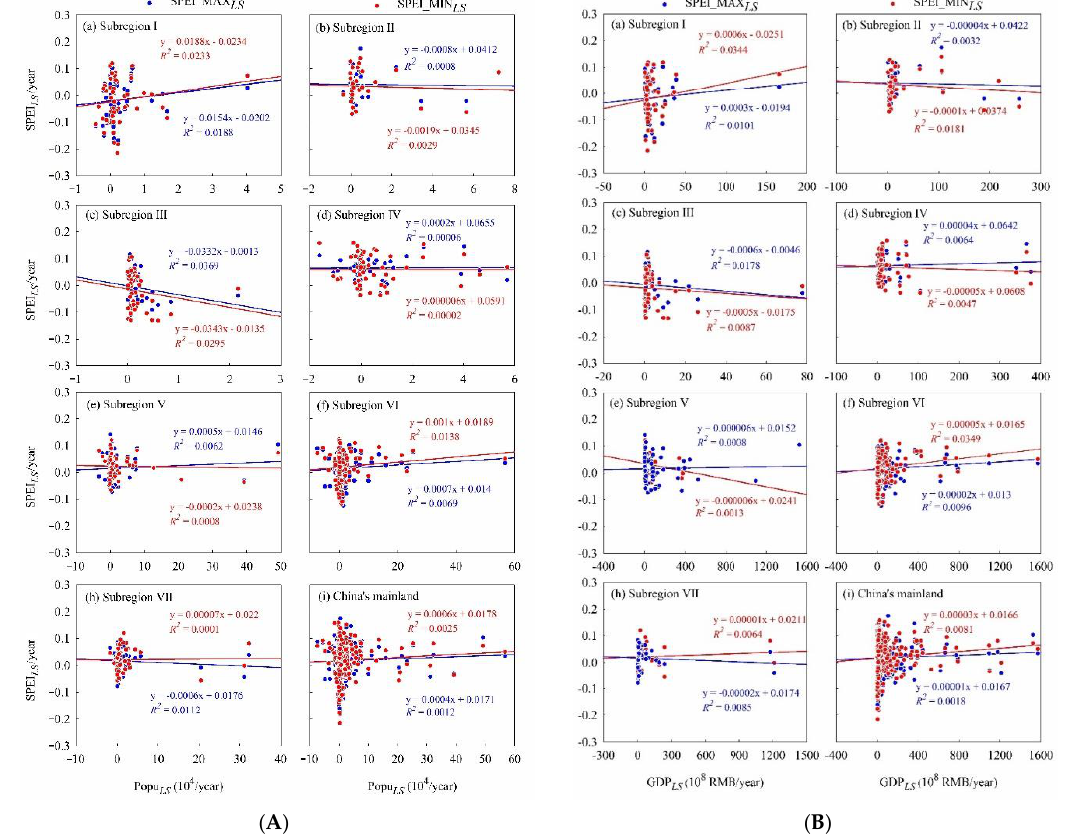
Figure 6. Relationship between Popu LS /GDP LS and SPEI_MAX LS /SPEI_MIN LS . ( A ) SPEI_MAX LS /SPEI_MIN LS vs. Popu LS . ( B ) SPEI_MAX LS /SPEI_MIN LS vs. GDP LS .